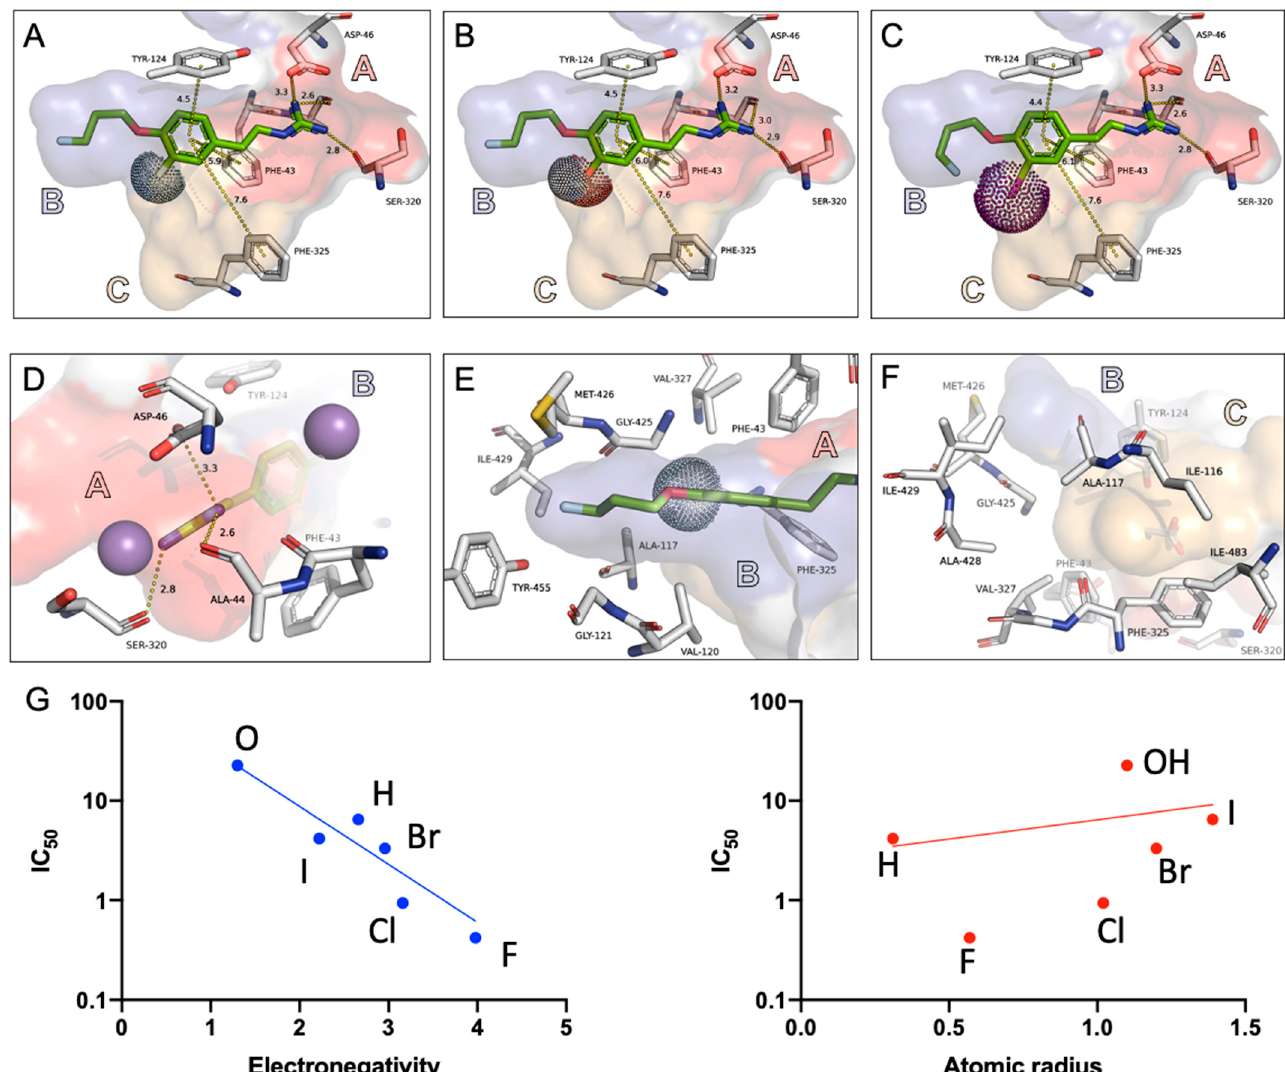
Figure 3. Different substitution pattern of the AF78 series (backbone of the common structure in green) in complex with Drosophila dopamine transporter with NET-like mutations (dDATNET, PDB6M0Z) [23]. The space occupied by the halogen atoms or the phenol function are visualized by dots. The two sodium ions of the transporter are shown as purple spheres out of scale for a better overview. The binding pockets are designated with letters A–C. Distances between the presented tracer and the transporter are shown in Å. The atomic radius of the halogens and the hydroxy group are displayed with dots in A–C. ( A – C ) Proposed binding mode of AF78(F), (OH) and (I), respectively, bound to the dDATNET. ( D ) Pocket A interactions of the guanidine moiety with ALA-44, ASP-46, SER-320 and two sodium ions (displayed in purple). ( E ) Visualization of Pocket B from a top-down perspective, which is surrounded by a group of nonpolar amino acid moieties (GLY-121, VAL-120, MET-426, ILE-429). ( F ) Amino acids forming the hinge region between Pocket B and C (ALA-117, GLY-425) and the surrounding nonpolar amino acid moieties that form the lipophilic Pocket C (ILE-113, ILE-483, VAL-327, ALA-117, VAL-113, PHE-325). ( G ) Correlation between NET affinities of cold references obtained from competitive cellular uptake assay and physical properties of the